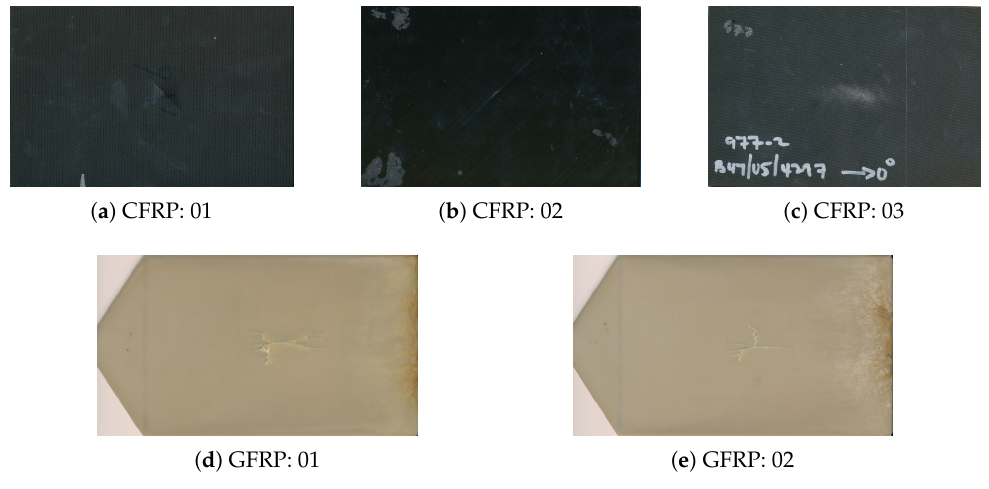
Figure 1. Photographs of the testing